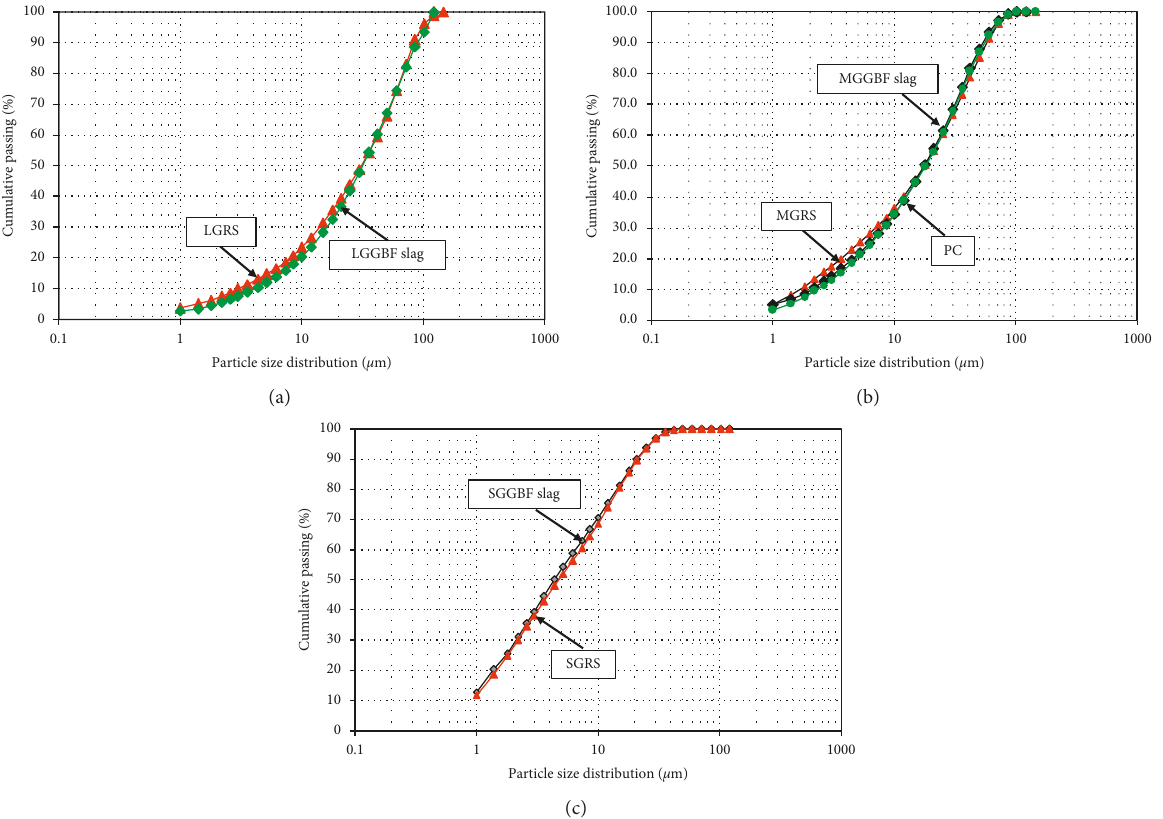
Figure 2: Particle size distributions of PC, GRS, and GGBF slag: (a) particle size distributions of LGRS and LGGBF; (b) particle size distributions of MGRS, MGGBF, and PC; (c) particle size distributions of SGRS and SGGBF.